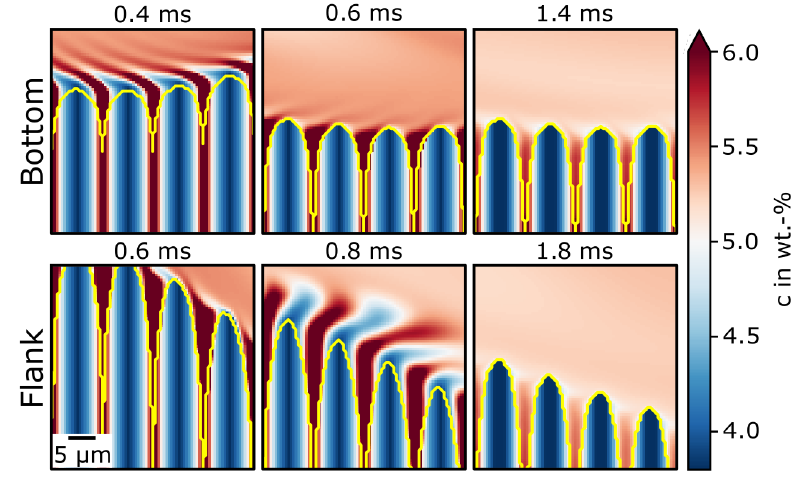
Figure 8. Temporal evolution of Nb composition during remelting at bottom and flanks (comparing Figure 7) at different times. Solid–liquid interface highlighted in